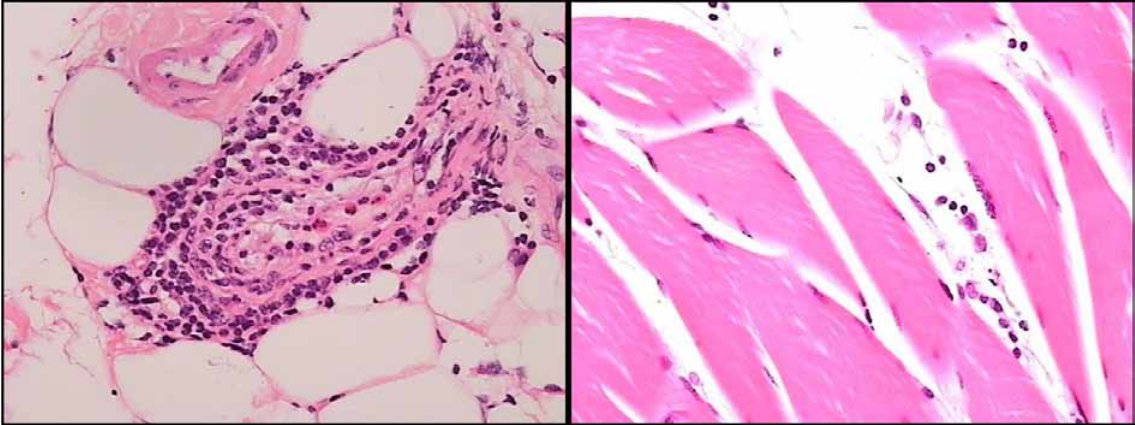
Figure 1. Muscle biopsy - perimysium and perivascular infiltration of muscle with CD68 positive macrophages, lymphocytes and eosinophils (14 days after initiation of glucocorticoid